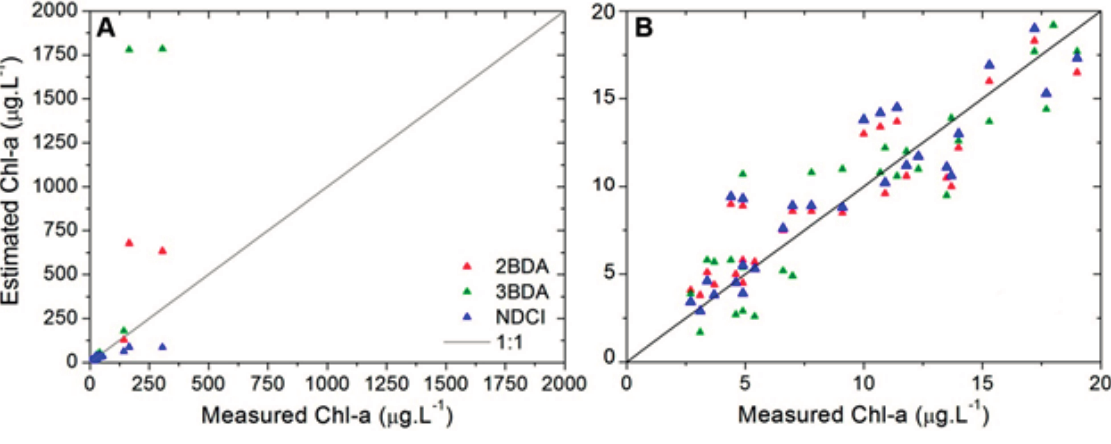
Figure 9. Scatterplots of the measured vs. estimated chl- a for each model using all in situ hyperspectral data. ( A ) All chl- a range; ( B ) Limiting the range to clarify the